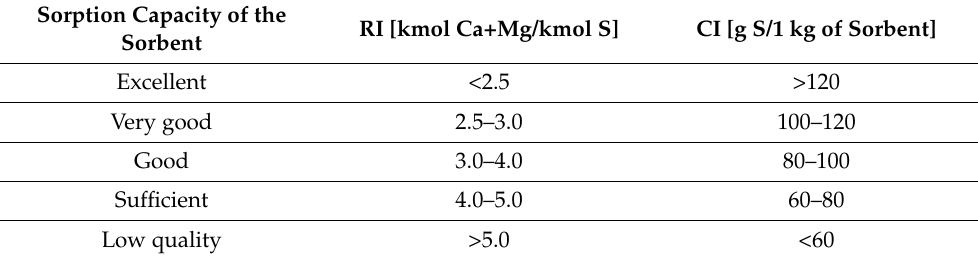
Table 2. Reference values of the reactivity (RI) [Ca moles/S moles] and the absolute sorption (CI) [g S/1000 g of the sorbent]